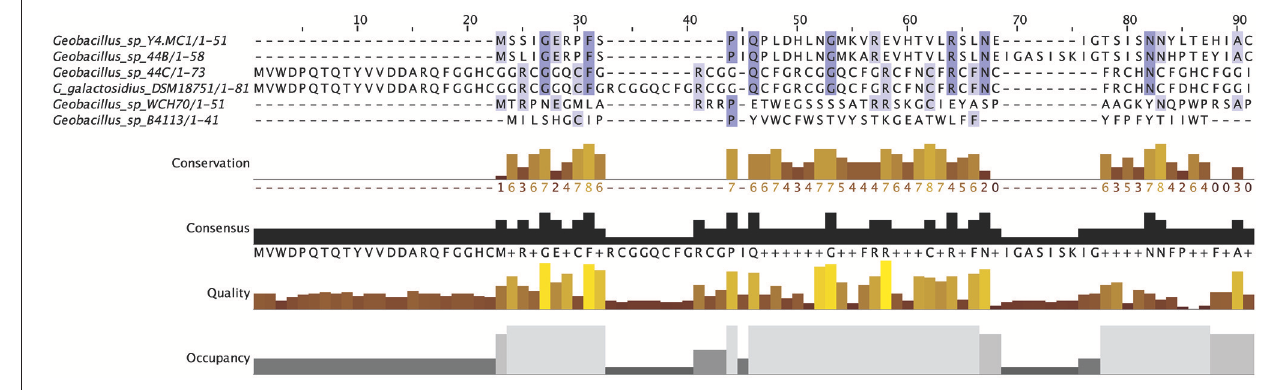
FIGURE 6 | Linear Azole containing peptides predicted by BAGEL3.